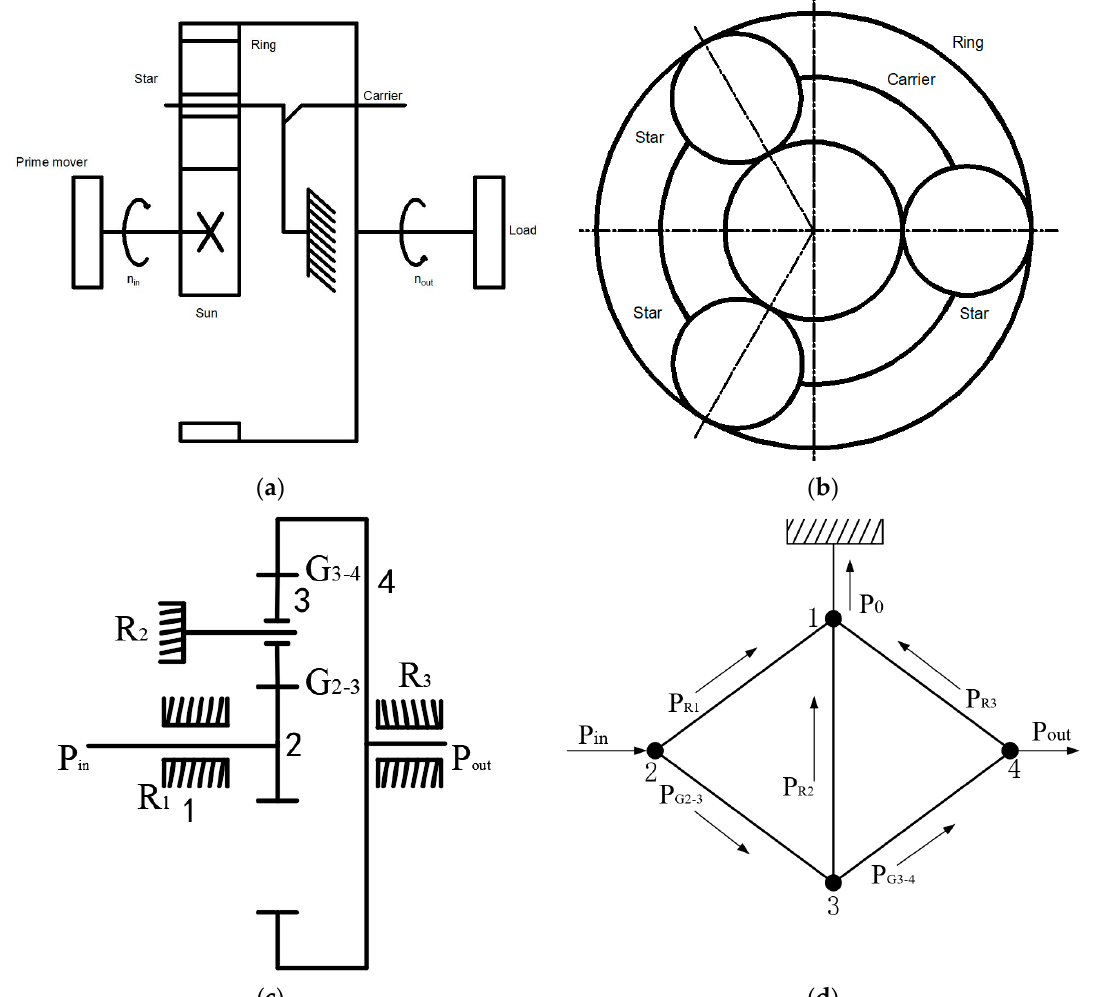
Figure 2. Schematic representation of herringbone planetary gear transmission system. ( a ) Herringbone planetary gear structure; ( b ) cross-sectional view of planetary gear; ( c ) schematic of transmission structure; ( d ) hypergraph of power loss mechanism (1, 2, 3, and 4 denote the frame, sun gear, planetary gear, and ring gear, respectively; R 1 , R 2 , and R 3 represent bearing contacts and G 2-3 and G 2-4 represent tooth surface contacts, respectively).